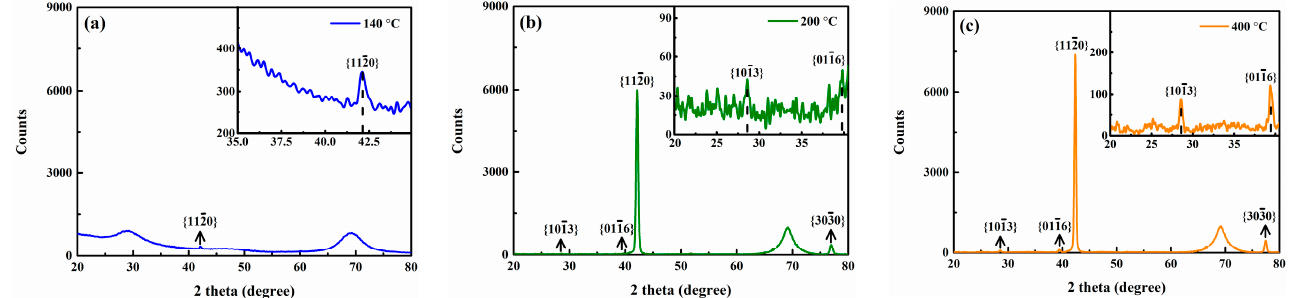
Figure 1. XRD patterns of Sb 2 Te thin films (200 nm) annealed at different temperatures: ( a ) 140 °C; ( b ) 200 °C; ( c ) 400 °C. The holding time is 30 min. The inset in ( a ) is an enlarged diffraction signal between 35.0° and 44.9°. The inset in ( c ) is a redrawn diffraction signal between 20.0° and 40.5°.